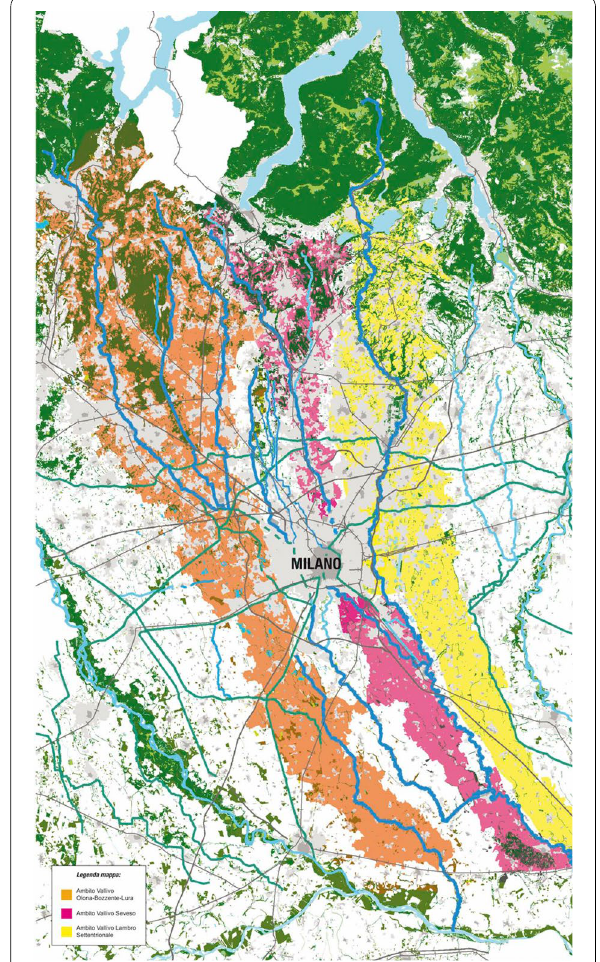
Fig. 1 Territorial framing of the stream Seveso river basin (Source: Contratto di fiume del